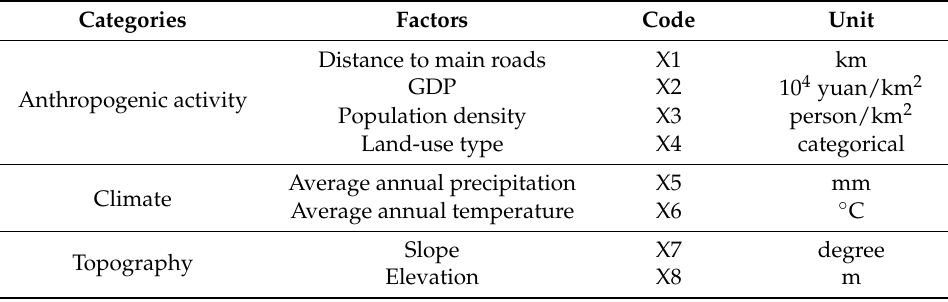
Table 2. Influencing factors of small and micro wetlands